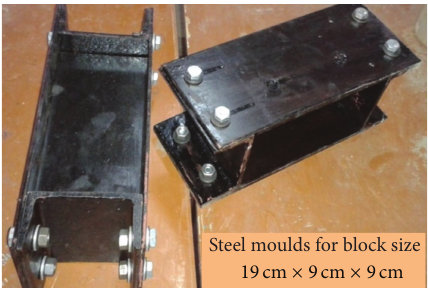
Table 1: Properties of soil.